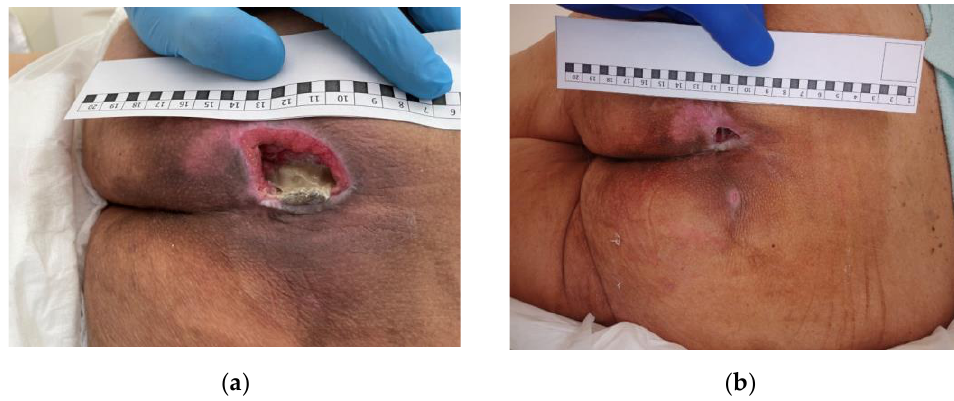
Figure 5. Dynamics of the pressure sore in the main group: ( a ) before treatment and ( b ) on the 30th day.